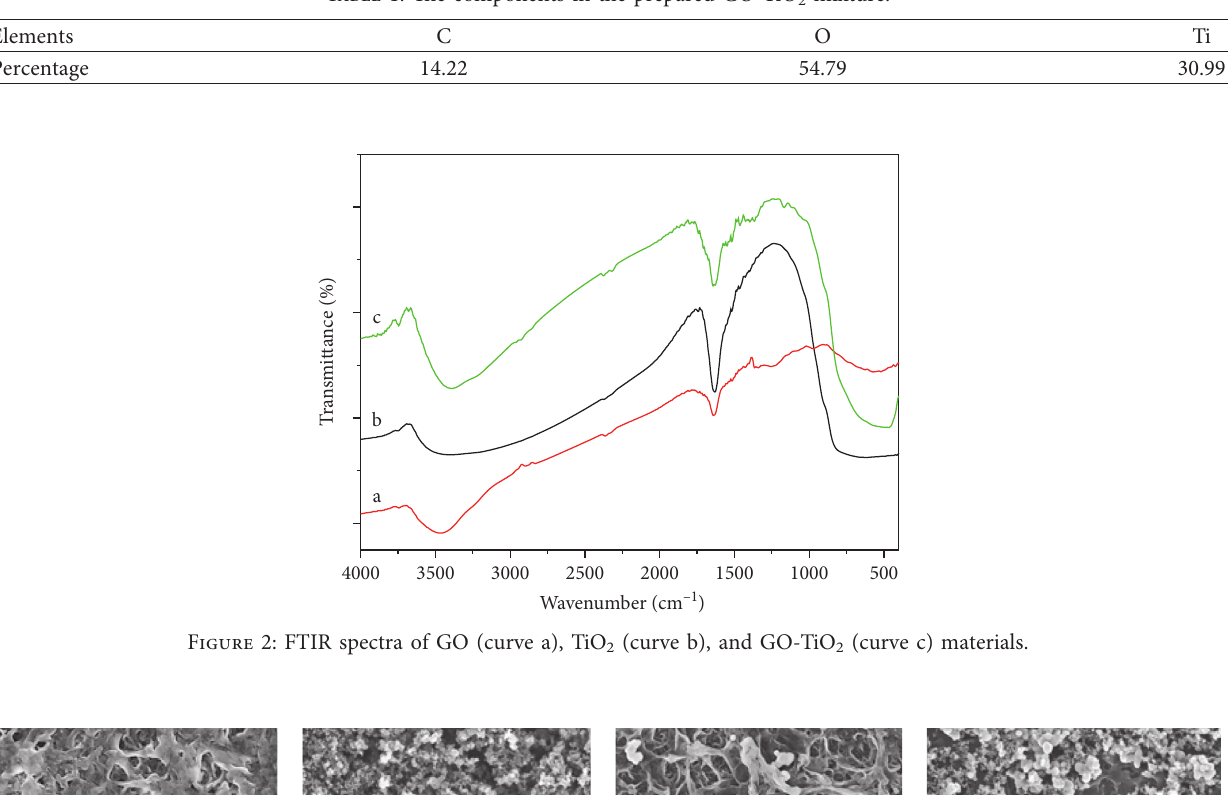
2 , and (d) PA/GO-TiO 2 membrane surfaces.